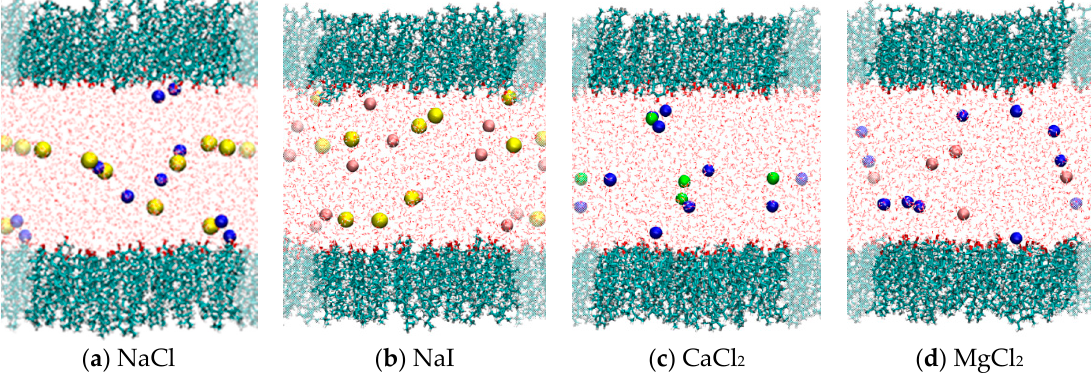
Figure 4. Snapshots from MD simulations ( T = 298 K) corresponding to simulations at a fixed area per molecule (40 Å 2 /molecule) but different electrolyte. CHOL molecules are shown in bond representation; water is shown as lines and ions as spheres with Van der Waals radii. ( a ) NaCl (yellow spheres: Na + ; blue spheres: Cl − ); ( b ) NaI (yellow spheres: Na + ; orange spheres: I − ); ( c ) CaCl 2 (green spheres: Ca 2+ ; blue spheres Cl − ) and; ( d ) MgCl 2 (orange spheres: Mg 2+ ; blue spheres: Cl − ). The shaded region indicates periodic boundary conditions. This figure was made with VMD software [29].